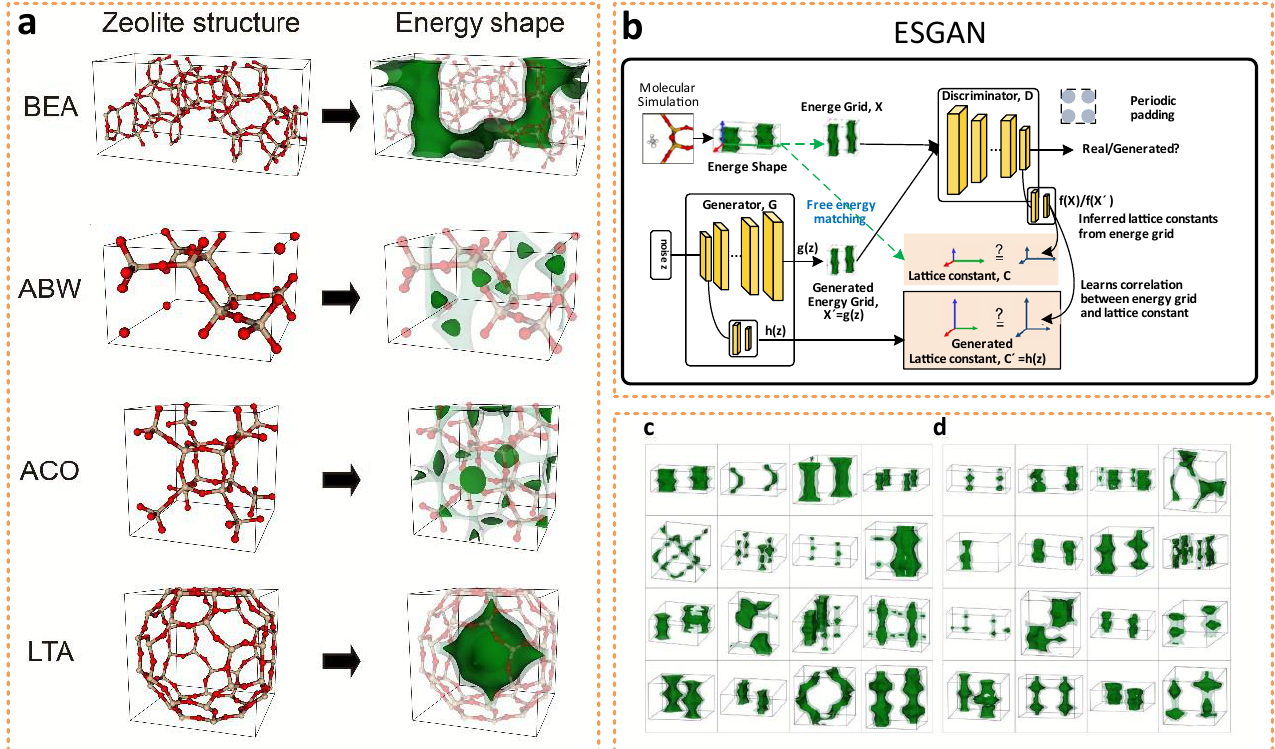
Figure 4. ( a ) Left column illustrates the unit cells of four prominent zeolites (BEA, ABW, ACO, LTA). Right column shows the corresponding methane potential energy profiles (i.e., shapes) computed from molecular simulations (dark green: low energy, light green: higher but accessible energy, white: inaccessible regions). ( b ) Overall schematics of ESGAN. ( c ) Real energy shapes of zeolites from Deem’s database, and ( d ) generated energy shapes from ESGAN. Reprinted with permission from Ref. [82]. Copyright 2019 Royal Society of